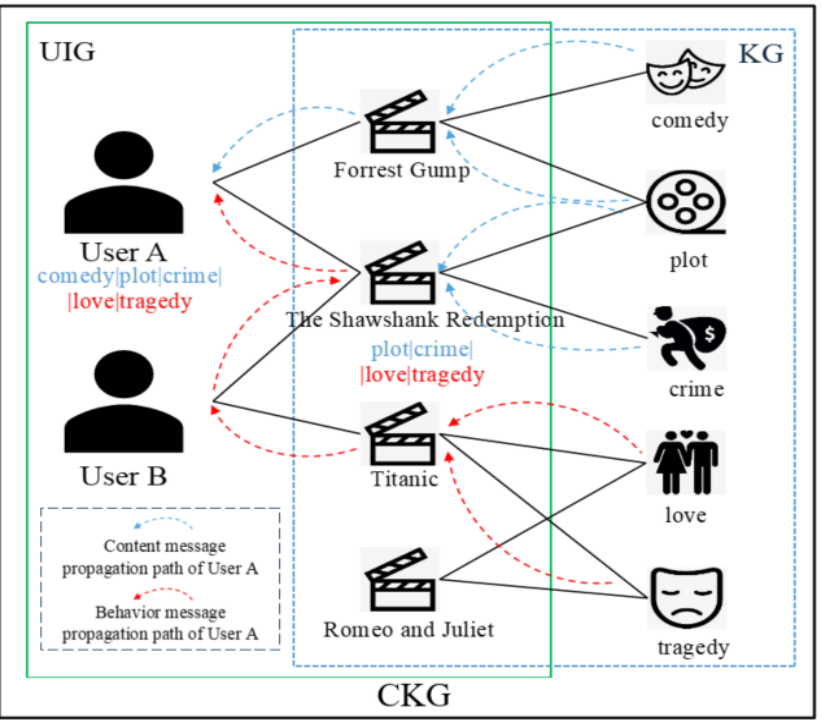
Figure 1. Message propagation on CKG.